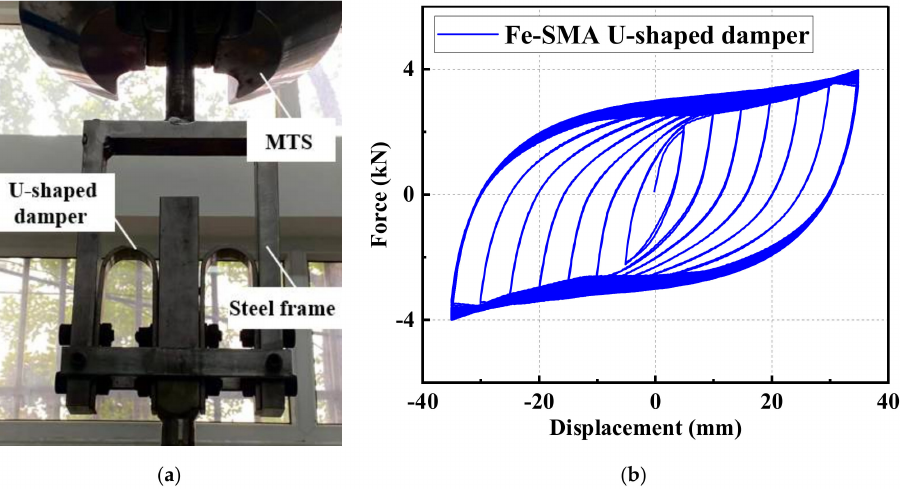
Figure 21. Fe-SMA U-shaped damper tests: ( a ) test setup; and ( b ) hysteretic response under incre- mental loading